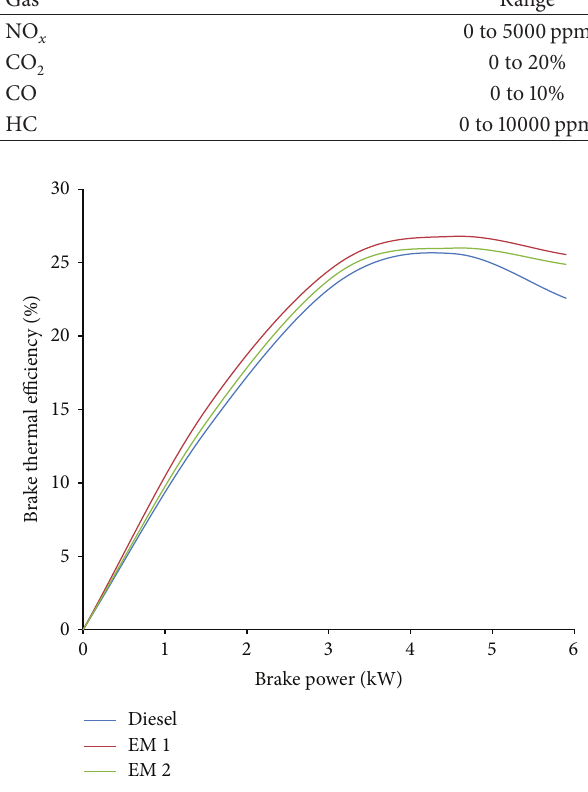
Figure 2: Brake power versus brake thermal efficiency.